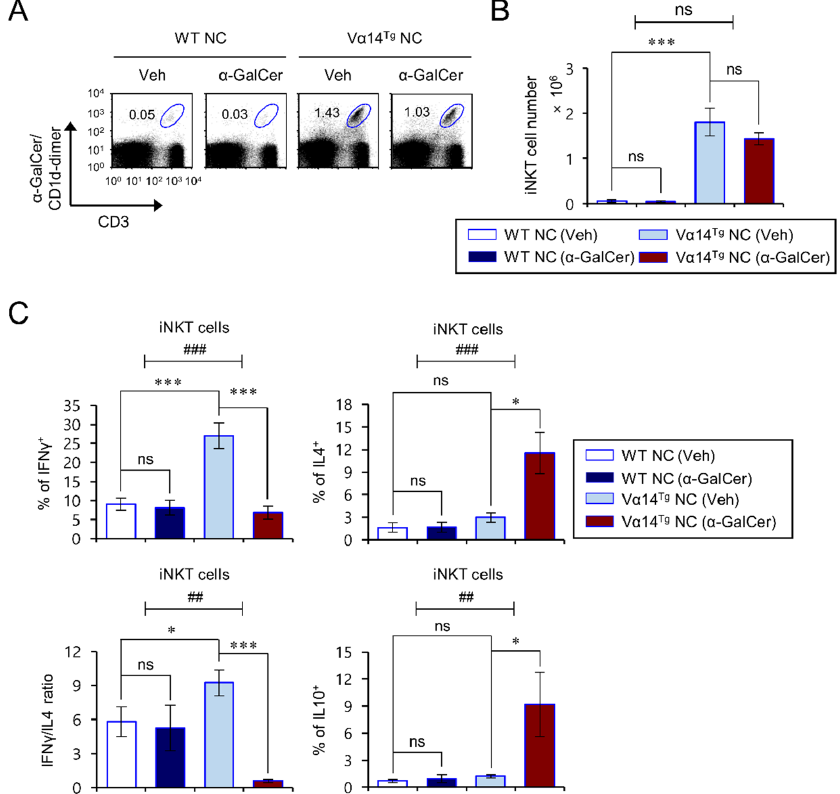
Figure 2. Repeated in vivo α -GalCer treatment changes the iNKT cell phenotype of V α 14 Tg NC mice towards type 2 cytokine production. ( A – C ) Spleens were prepared from mice as shown in Figure 1. ( A , B ) The frequency and cell number of splenic iNKT cells ( α -GalCer/CD1d-dimer + CD3 + ) were determined by flow cytometry. ( C ) Intracellular IFN γ , IL4, and IL10 were analyzed in splenic